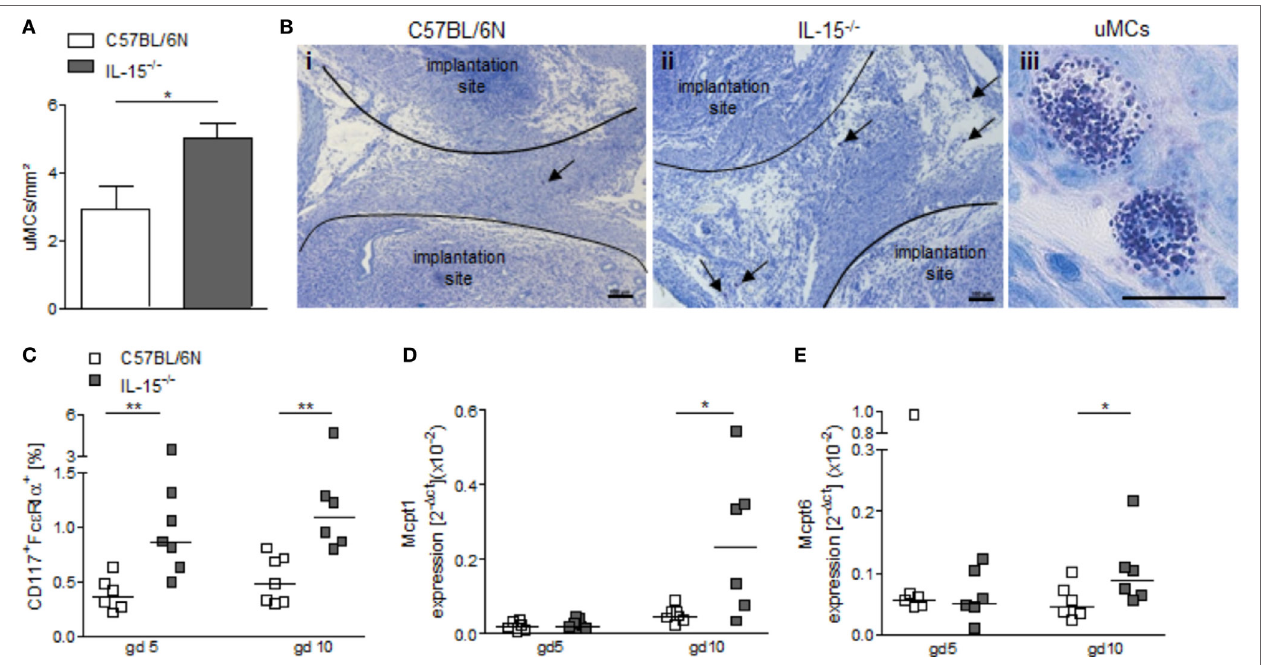
FigUre 4 | Interleukin (IL)-15 − / − mice exhibit increased numbers of uterine mast cells (uMCs). (a) Numbers of uMCs per 1 mm 2 were quantified in tolouidine blue-stained 5 µm paraffin sections from uteri of C57BL/6N ( n = 6) and IL-15 − / − mice ( n = 6) at gd5. Results are presented as mean with SEM. Statistical differences were obtained using Mann–Whitney U -test (* P < 0.05). (B) Representative pictures for (a) are shown for C57BL/6N (i) and IL-15 − / − (ii) mice (scale bar = 100 μ m). uMCs (iii) are localized between the implantation sites and are indicated by arrows (scale bar = 20 μ m) in (i) and (ii). (c) Percentages of CD117 + Fc ε R α + MCs in uterus (gd 5) or decidua (gd 10) samples were analyzed by flow cytometry. mRNA levels of MC-related proteases (Mcpt)-1 (D) and Mcpt-6 (e) in uterine (gd 5) and decidual (gd 10) tissue of BL/6N and IL-15 − / − mice were measured. For (c–e) , results are presented with squares showing individual values. Additionally, the medians are indicated. Statistical differences were obtained using non-parametric Mann–Whitney U -test (* P < 0.05, ** P < 0.005). IL, interleukin; uMC, uterine mast cell; Mcpt, MC-related